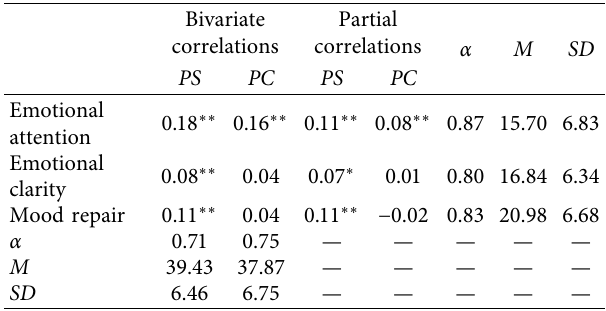
partial correlations between the factors of the CAPS and